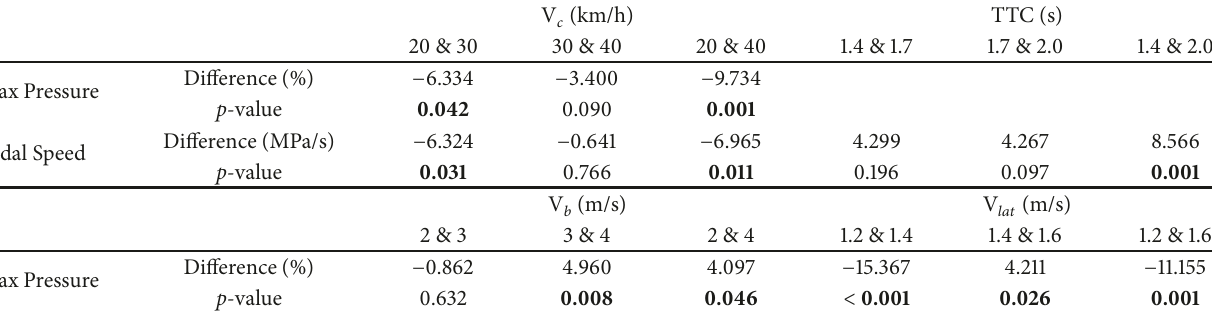
Table 7: Post hoc analysis for Max Pressure and Pedal Speed in SSR.